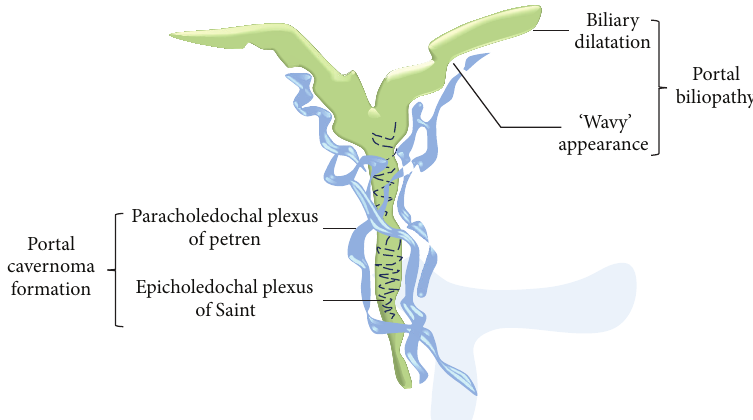
Figure 44: Graphic illustration demonstrating opening up of epi- and paracholedochal venous collaterals in chronic PVT causing portal biliopathy.